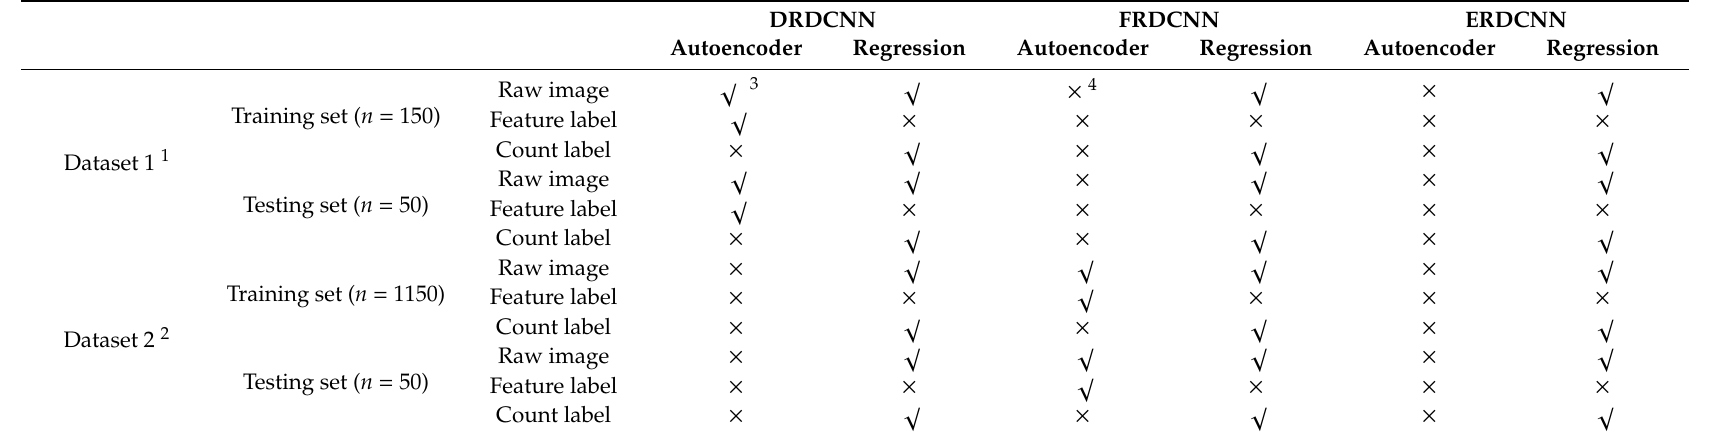
Table 2. The three regression DCNN